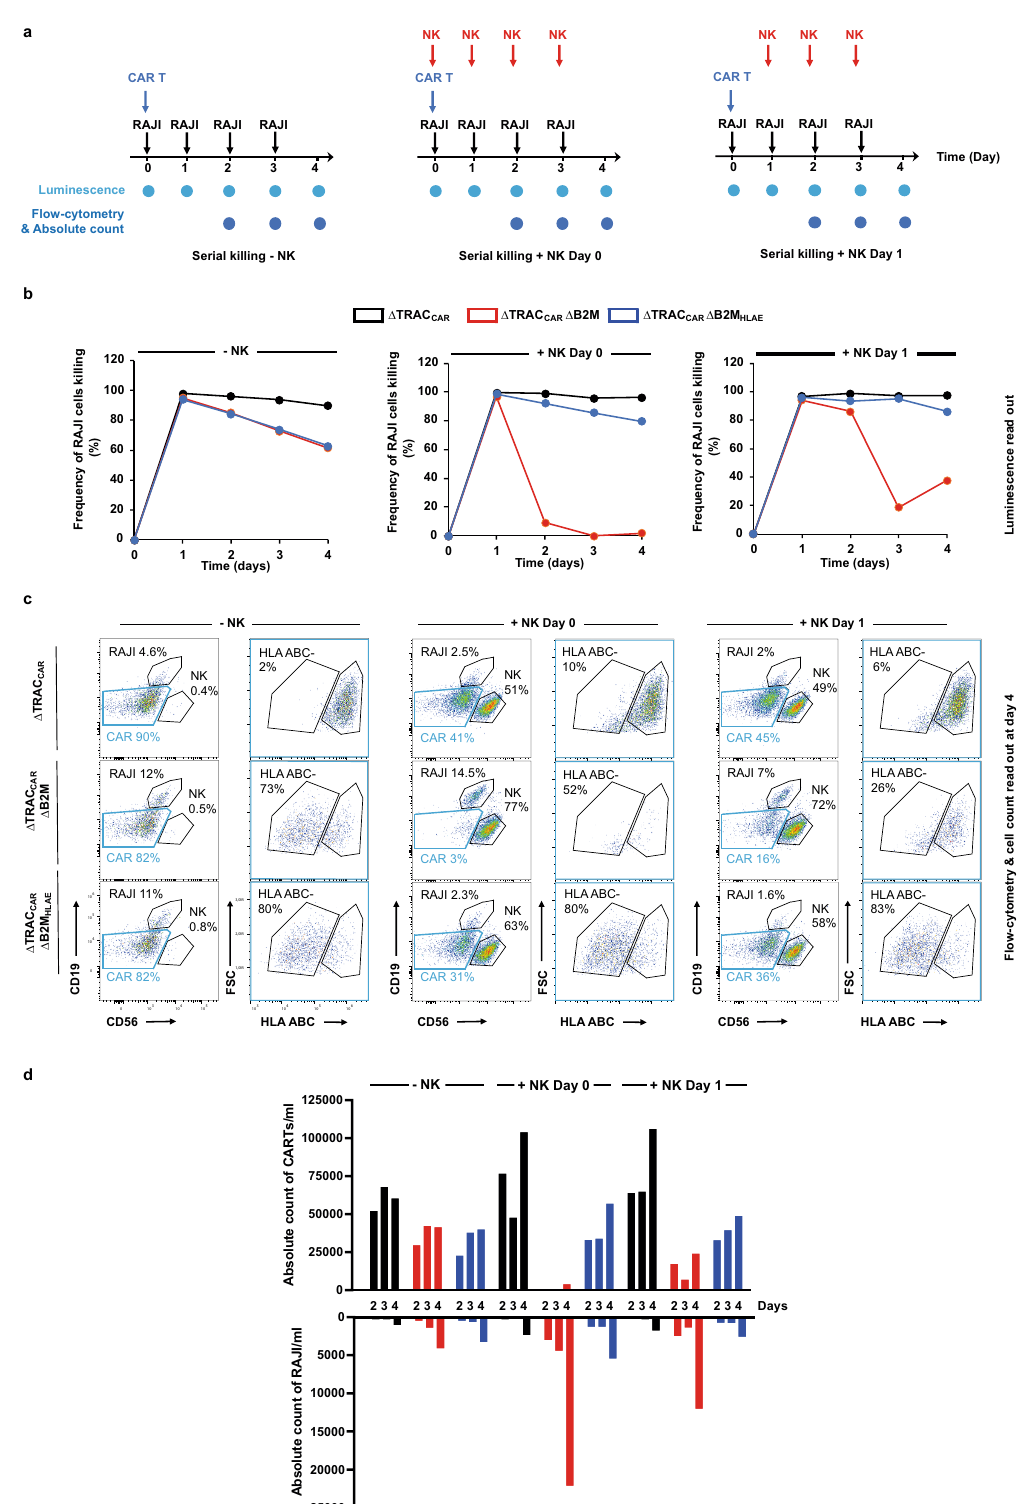
relative enrichment of HLA-E( + ) over HLA-E( − ) subpopula- tions in mice engrafted with allogeneic PBMCs. Four days after CAR T-cell engraftment, we observed an enrichment of HLA- ABC( − ) HLA-E( + ) Δ TRAC CAR123 Δ B2M HLAE cells in the spleen relative to their HLA-ABC( − ) HLA-E( − ) counterparts (Fig. 6c